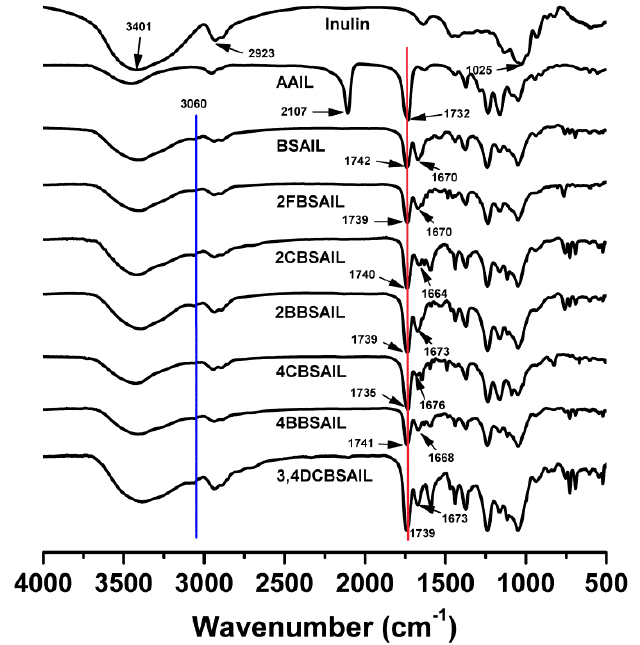
Figure 1. FTIR spectra of inulin, 6-azido-6-deoxy-3,4-di-O-acetyl inulin (AAIL), and inulin derivatives.